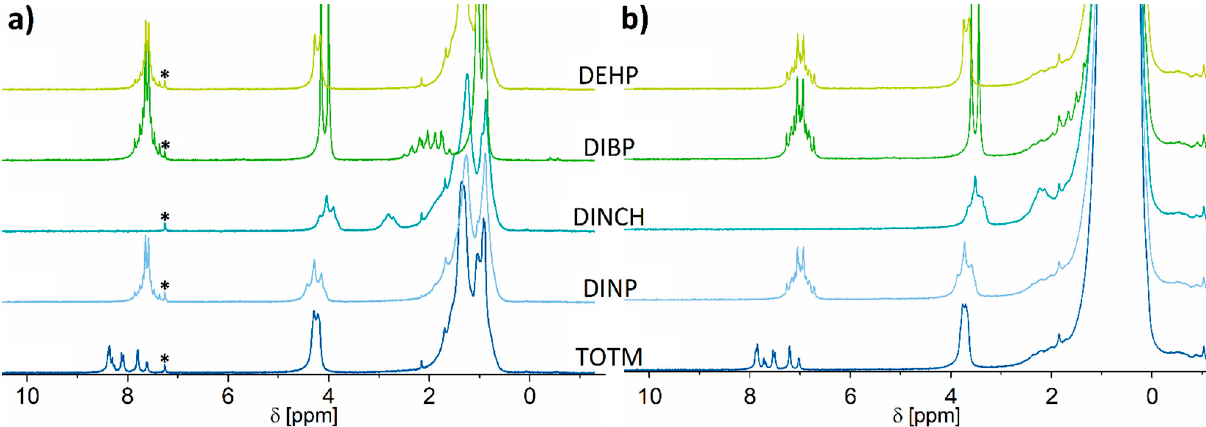
Figure 2. 40 MHz 1 H NMR spectra of the investigated plasticizers at concentrations of 10 vol.% in ( a ) deuterated chloroform and ( b ) non-deuterated n-hexane. Spectra have been referenced to the residual deuterated chloroform (signal marked with asterisk at 7.26 ppm) and n-hexane (0.8 ppm) peaks, respectively. The difference in the chemical shift of ~0.5 ppm in the signals in the two subfigures can be attributed to solvent effects. Most of the spectra are zoomed in on for a better view of the signals above 2 ppm.